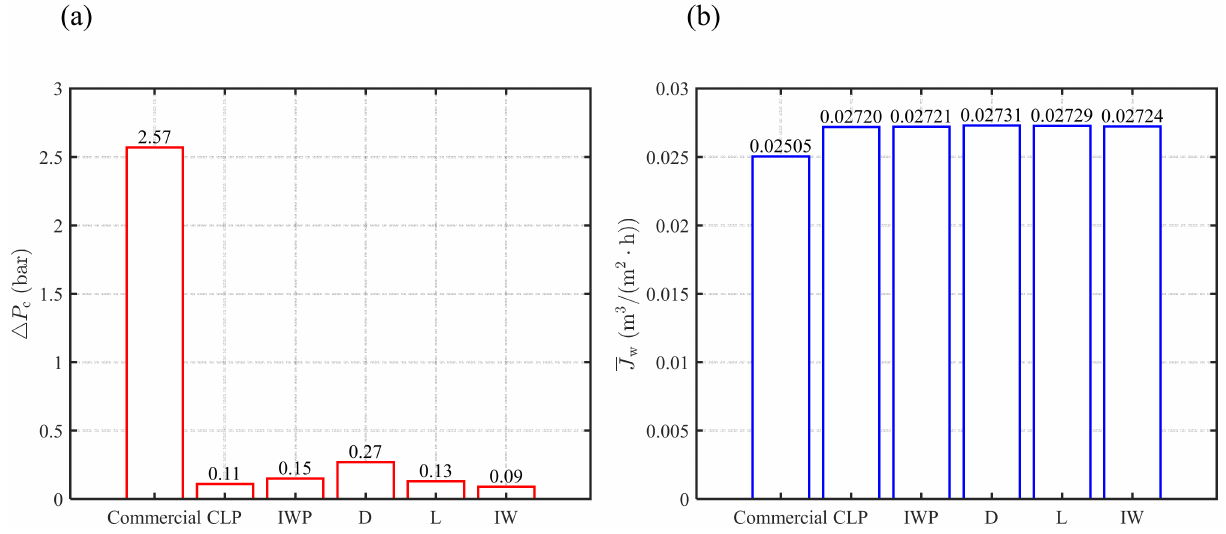
Figure 6. ( a ) The total pressure drop (difference value between the average pressure at the inlet and the average pressure at the outlet), ∆ P c (bar), and ( b ) average permeation flux of water, J w (m 3 /(m 2 · h)), for the whole RO